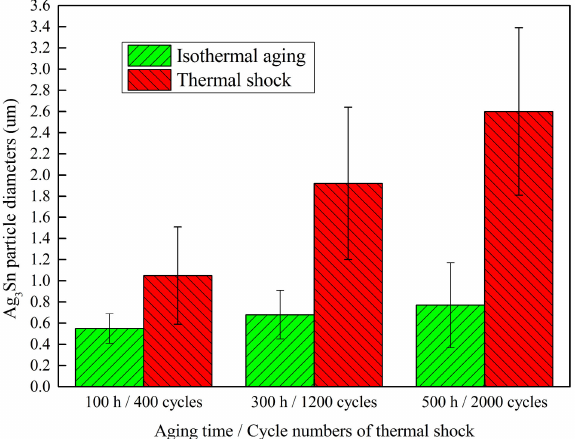
Figure 3. Cross-sectional BSE images of SAC305 micro-joints in flip chip assembly: ( a ) After 500 h aging time; ( b ) after 2000 thermal shock (TS) cycles.